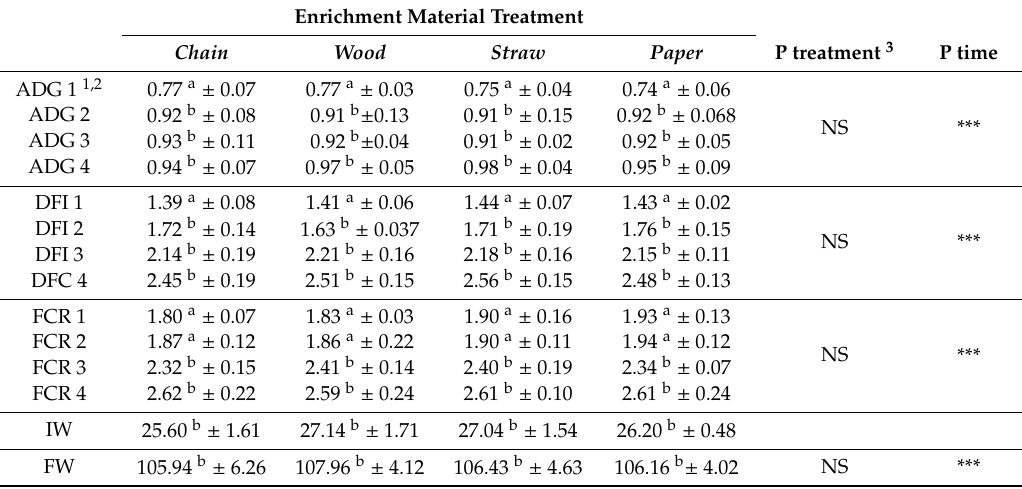
Table 4. The Mean (and standard deviations) of Average Daily Gain, Daily Feed Intake and Feed Conversion Ratio for the four types of enrichment material at di ff erent periods (1 to 4) and of the initial Weight and Final Weight.